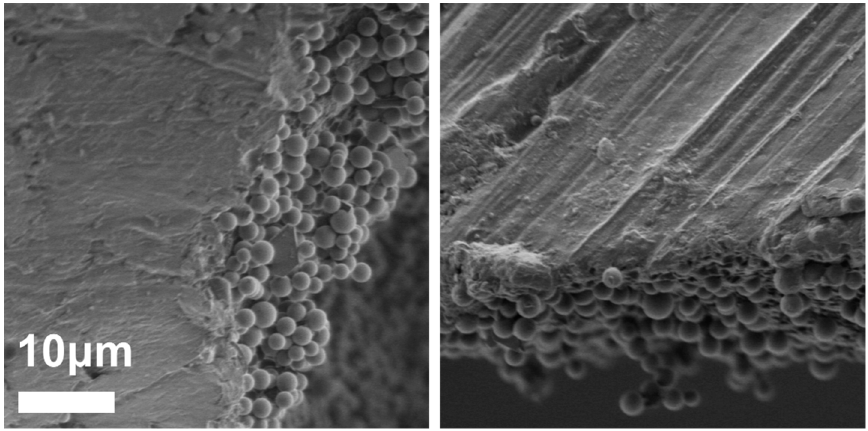
Figure 4. Cross-sectional SEM micrographs of the PC/PMSQ microsphere. It is evident that no PMSQ particles are located inside the PC matrix.